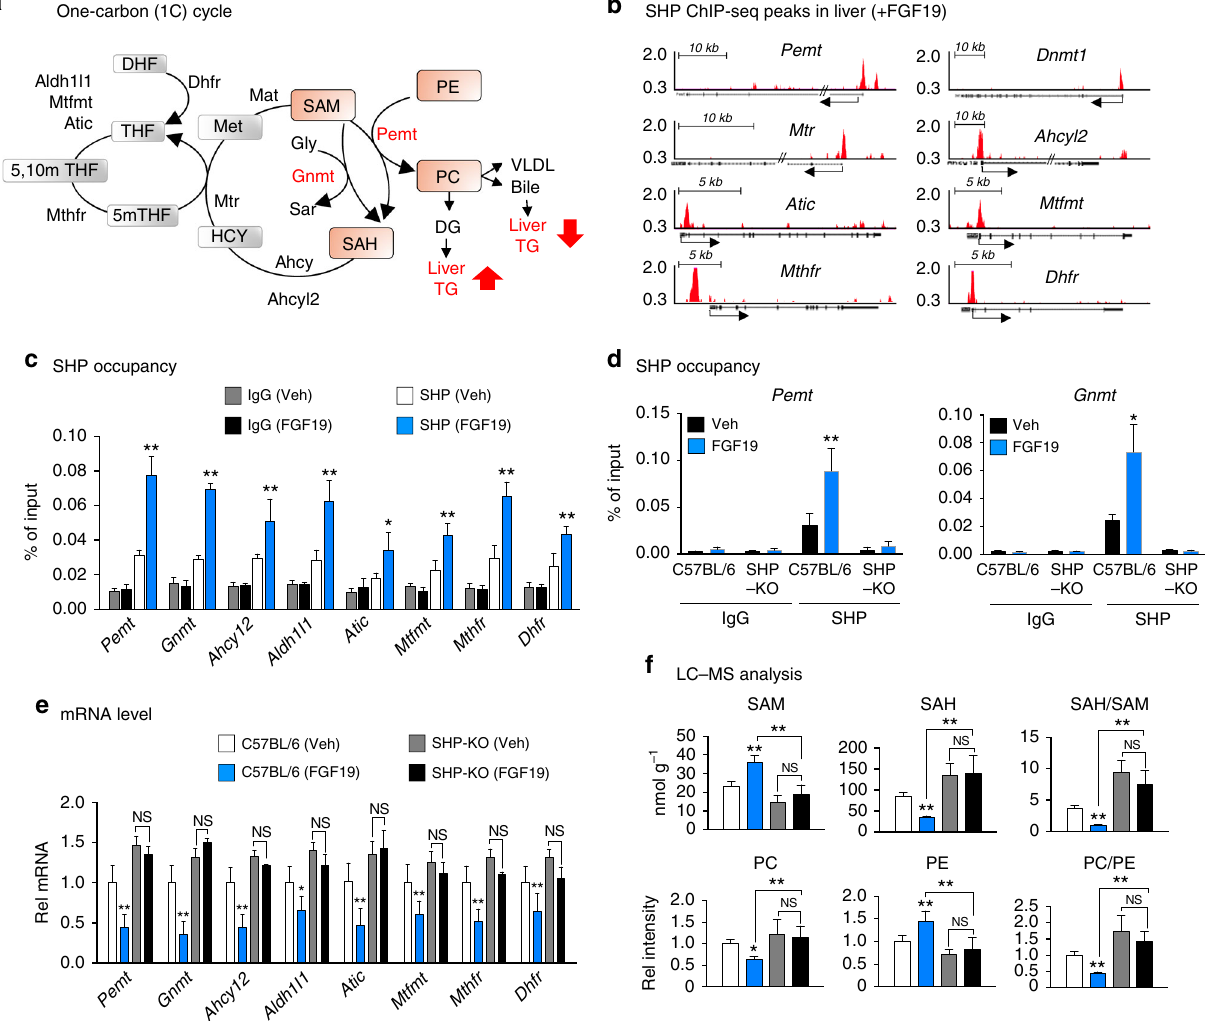
Fig. 1 FGF19 inhibition of hepatic PC production is SHP dependent. a Schematic diagram of the 1C cycle. b From liver ChIP-seq data for mice treated with FGF19 26 , positions of SHP binding peaks at the promoter regions of key genes involved in the 1C cycle are shown. c , d Effects of FGF19 treatment for 2 h on SHP occupancy determined by ChIP at 1C genes in C57BL/6 mice ( c ), and comparison of occupancy of SHP at Pemt and Gnmt genes in C57BL/6 and SHP- KO mice ( d ). e , f C57BL/6 or SHP-KO mice were treated with FGF19 for 6 h, and mRNA levels of 1C cycle genes ( e ) or 1C cycle metabolites levels ( f ) were determined by qRT-PCR or LC – MS, respectively. c – f Means ± SD are shown ( n = 5 mice), and statistical signi fi cance was measured using the two-way ANOVA with the FDR post-test and * P < 0.05, ** P < 0.01, NS, not statistically signi fi